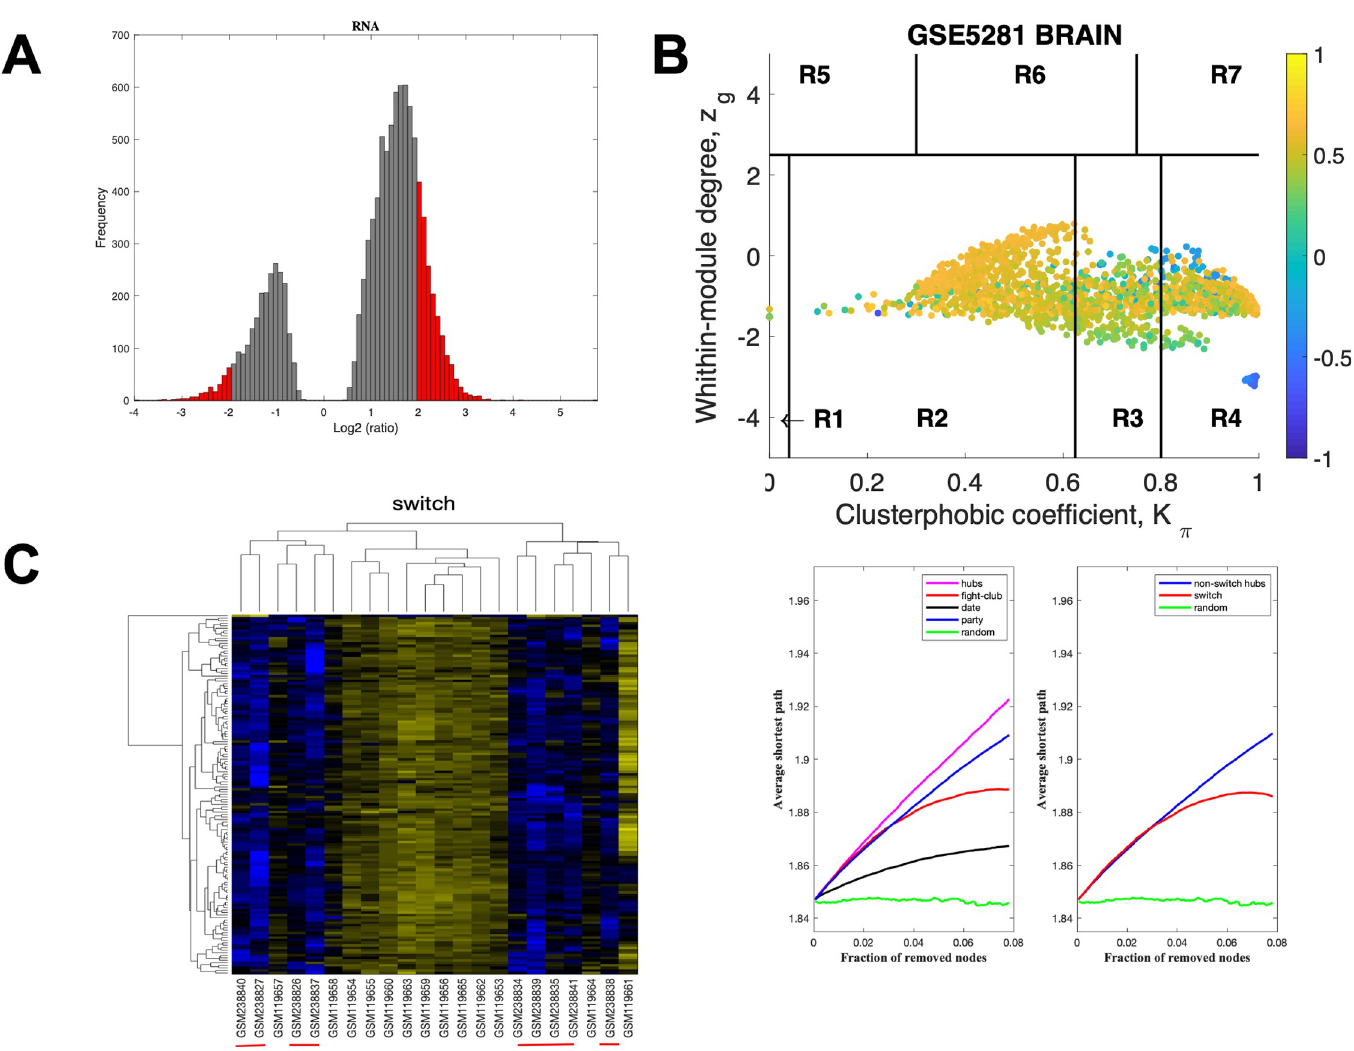
Fig 6. SWIM analysis of the posterior cingulate. A. Distribution of the fold-change values for GSE5281 brain microarray gene expression data from the PC. The x-axis represents the fold-change value (log2 of the fold-change) that is the ratio of the average expression data in AD patients compared to the average expression data in normal controls computed for protein-coding and non-coding RNAs. The y-axis represents the frequency of the obtained fold-change values. The grey bars represent the fold- change values associated with protein-coding and non-coding RNAs that will be discarded according to the selected threshold. The red bars represent the fold-change values associated with protein-coding and non-coding RNAs that were retained for further analysis. B. Heat cartography map for GSE5281 brain data from the PC. correlation network. The plane is identified by two parameters: Zg (within-module degree) and Kπ (clusterphobic coefficient) and it is divided into seven regions each defining a specific node role (R1-R7). High Zg values correspond to nodes that are hubs within their module (local hubs), whereas low Zg values correspond to nodes with few connections within their module (non-hubs within their communities, but they could be hubs in the network). Each node is colored according to its average Pearson Correlation coefficient (APCC) value. Yellow nodes are party and date hubs, which are positively correlated in expression with their interaction partners. Blue nodes are the fight-club hubs, which have an average negative correlation in expression with their interaction partners. Blue nodes falling in the region R4 are the switch genes, which are characterized by low Zg and by high Kπ values and are connected mainly outside their module. C. Dendrogram and heat map for switch genes in GSE5281 brain microarray gene expression data from the PC. The expression profiles of switch genes (including protein-coding and non-coding RNAs) are clustered according to rows (switch genes) and columns (samples) of the switch genes expression data (biclustering). The colors represent different expression levels that increase from blue to yellow. The red line under the x axis labels denotes AD samples. D. Robustness for the GSE5281 brain correlation network from the PC. The x-axis represents the cumulative fraction of removed nodes, while the y-axis represents the average shortest path. The shortest path between two nodes is the minimum number of consecutive edges connecting them. Each curve corresponds to the variation of the average shortest path of the correlation network as function of the removal of nodes specified by the colors of each